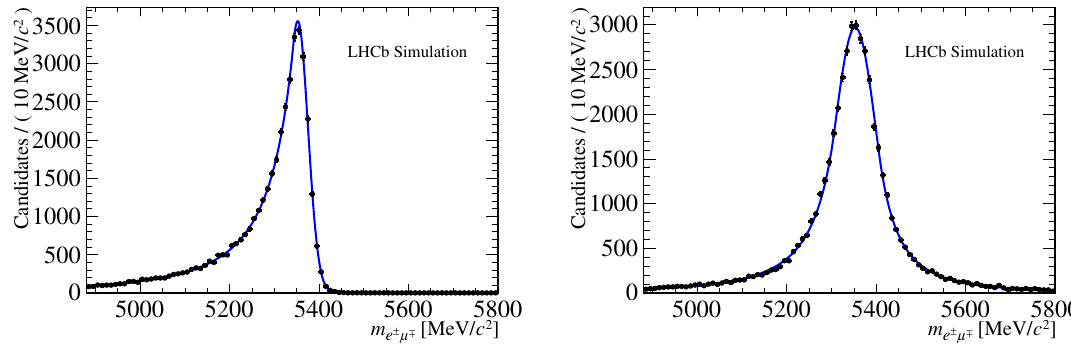
Figure 3 . Distribution of the m invariant mass of simulated B 0 candidates with no (left) e (cid:6) (cid:22) (cid:7) s and one or more (right) recovered bremsstrahlung photons. The overlaid (cid:12)t function is a modi(cid:12)ed Crystal Ball function with two tails on opposite